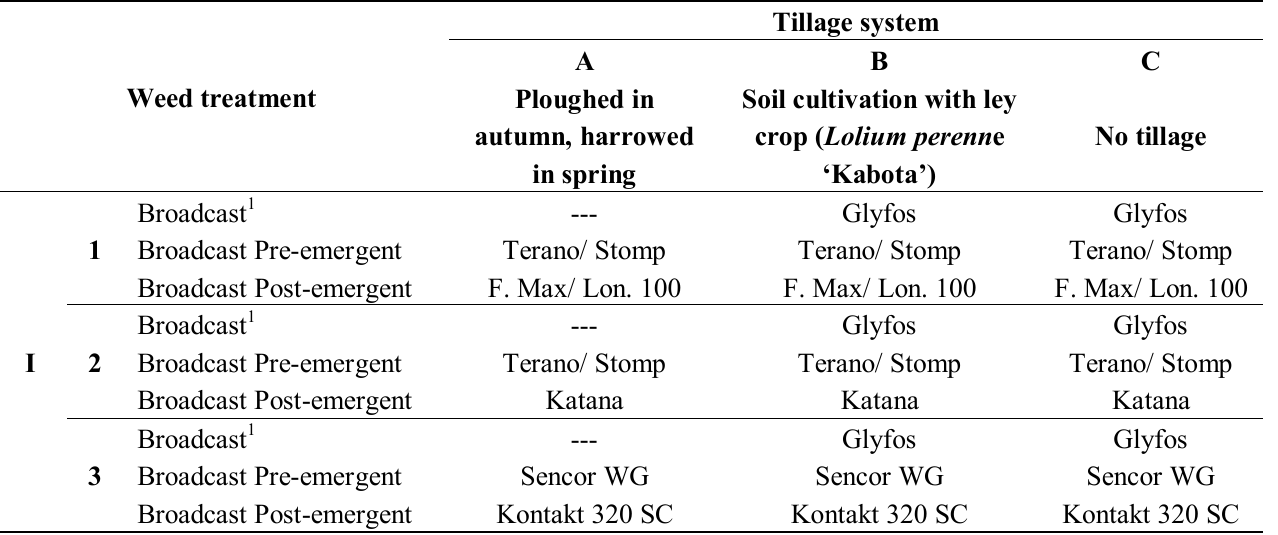
Table 3. Tillage systems specifying herbicide and/or mechanical weed treatment combinations for each